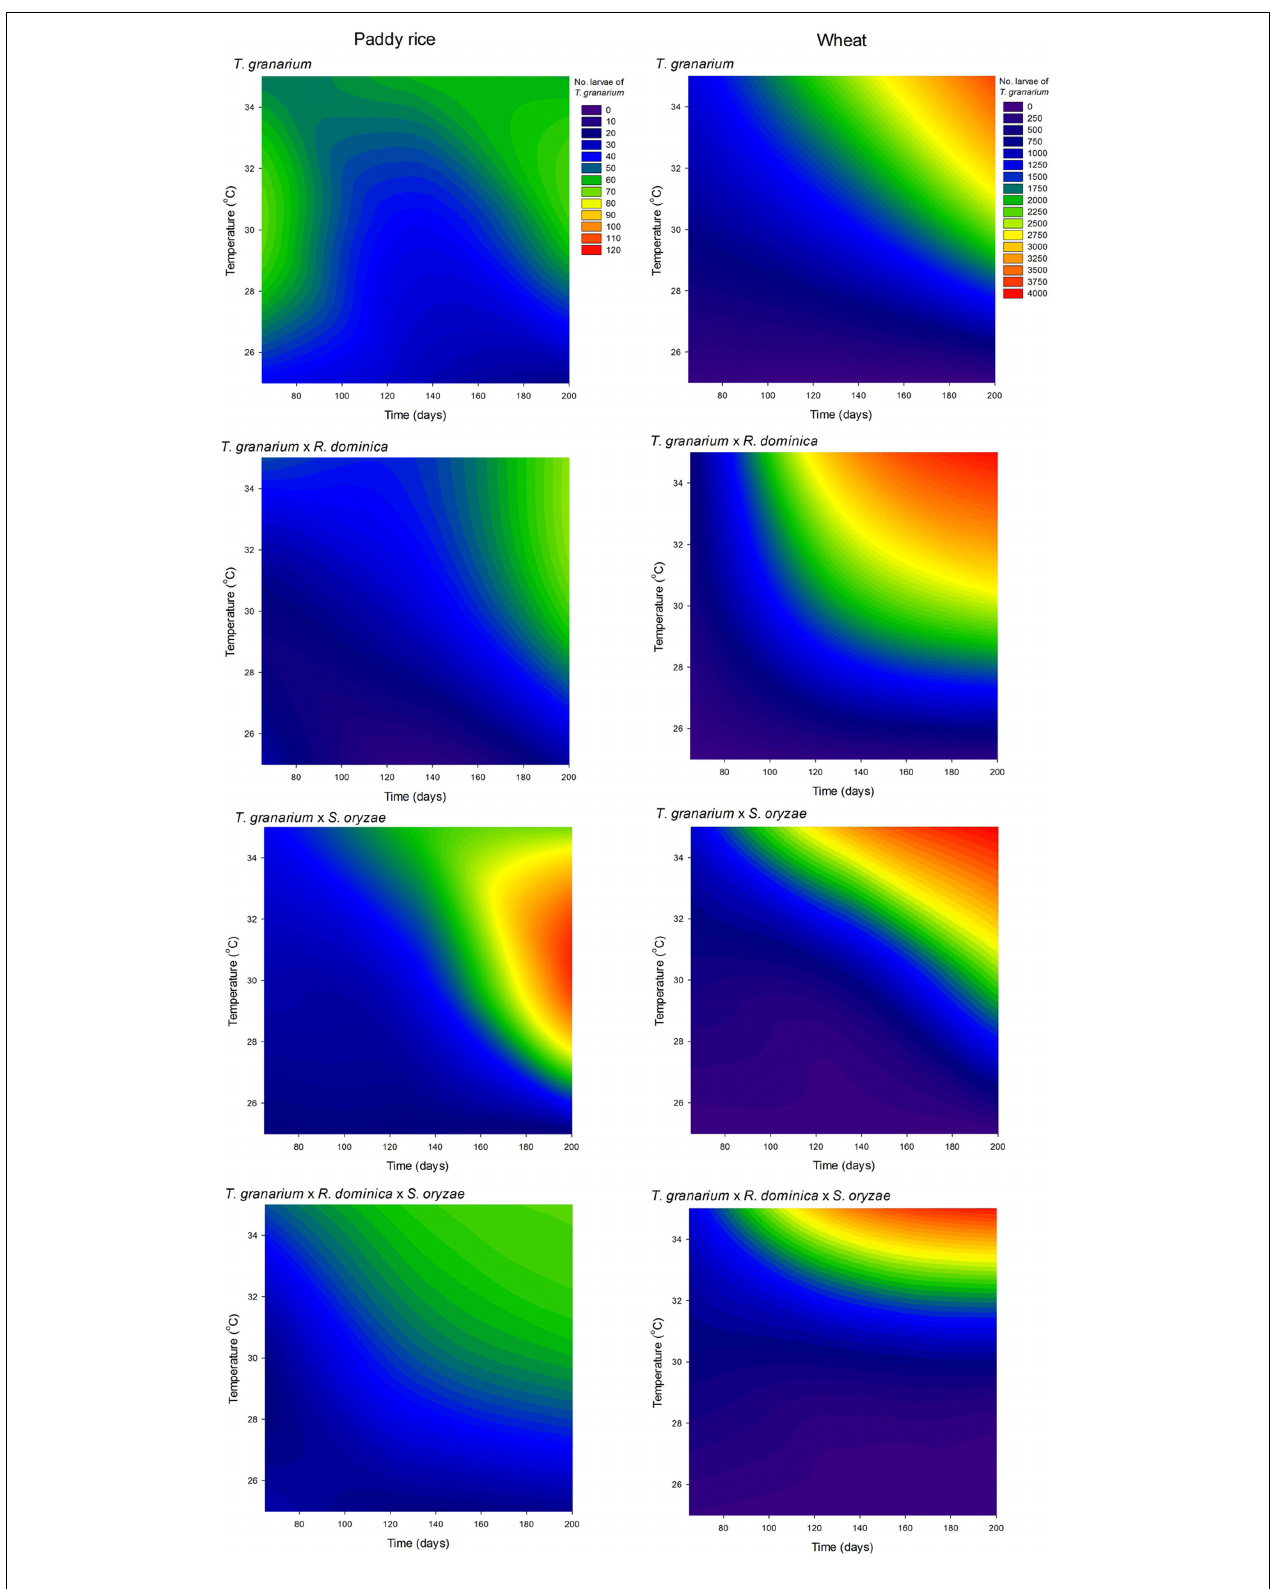
FIGURE 10 | Filled contour plots exhibiting the effect of storage time and temperature on the larva population of T. granarium in grains of two cereal host species, paddy rice and wheat, and under different competition scenarios.